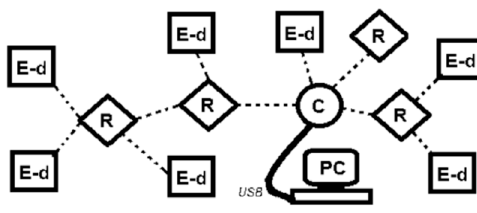
Figure 4. A ZigBee mesh network.